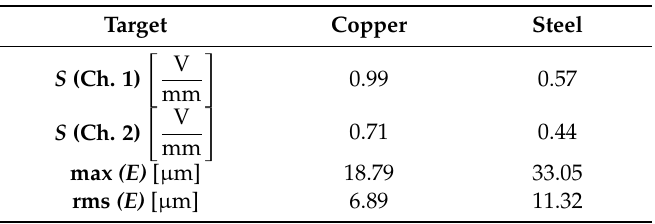
Table 2. The comparison of the sensitivities S and errors E for the both targets for results given in Figure 15.